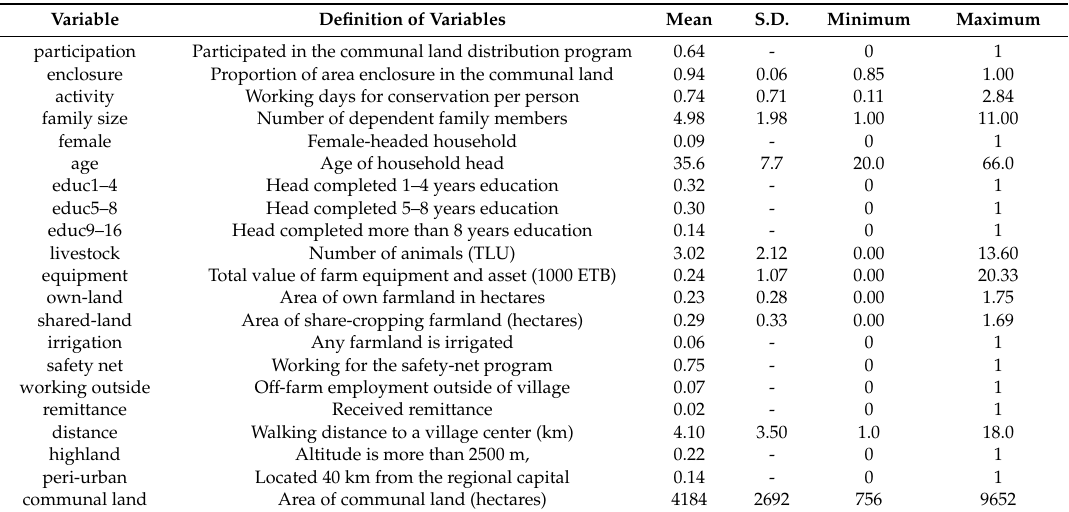
Table 1. Descriptive statistics of